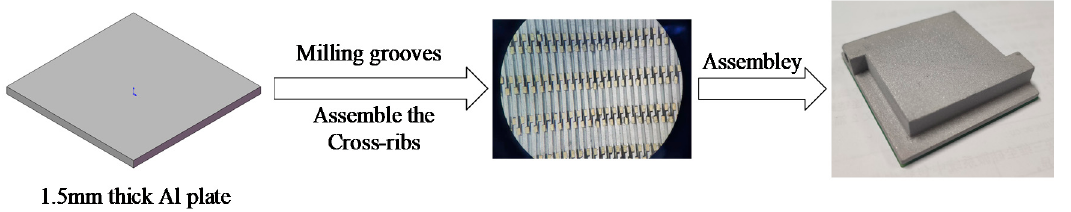
Figure 2. Assembly process.